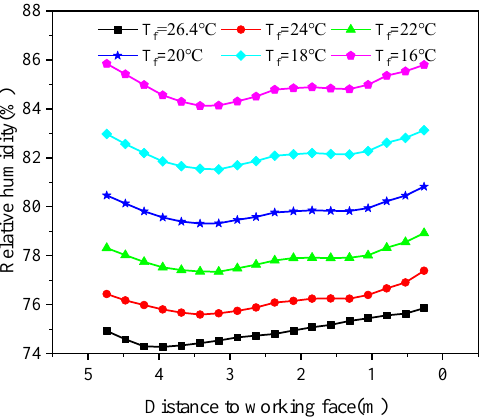
Figure 12. Wet bulb temperature distribution of drift centerline under different supply air te m per- atures.